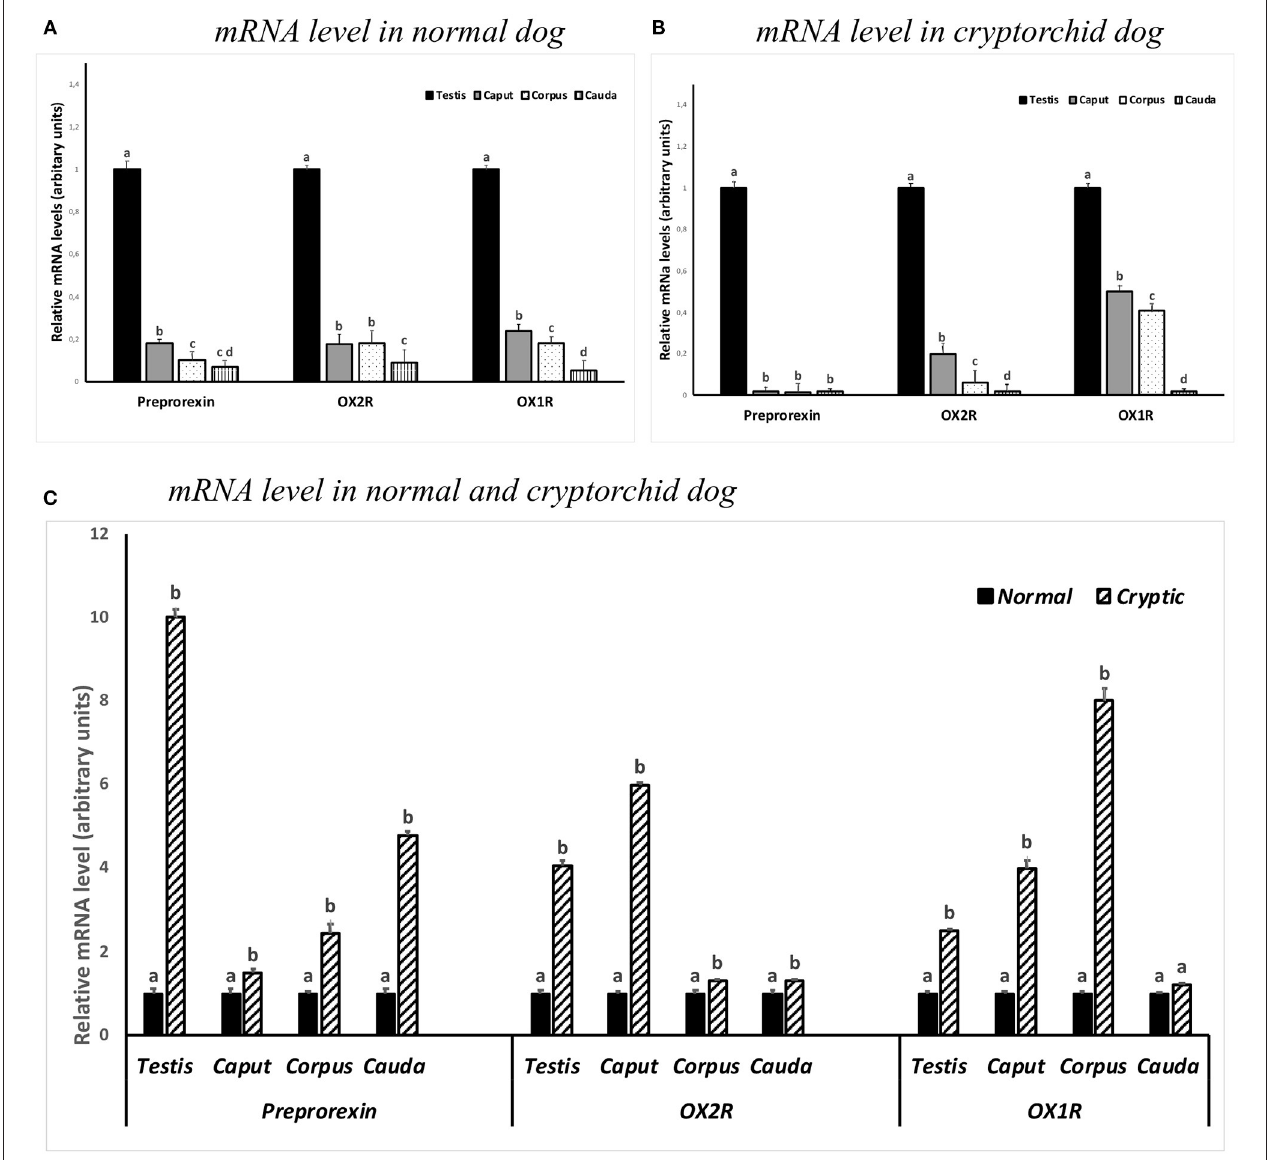
FIGURE 5 | PPO , OX1R and OX2R mRNA levels in the normal (A,C) and cryptorchid dogs (B,C) . (A) The calibrator is the normal testis; (B) the calibrator is cryptorchid testis; (C) the calibrator is the segment of the normal dog. Each value is expressed as the mean ± standard deviation (SD) obtained from three independent experiments. Different letters depict differences between the examined groups ( n = 5; p <